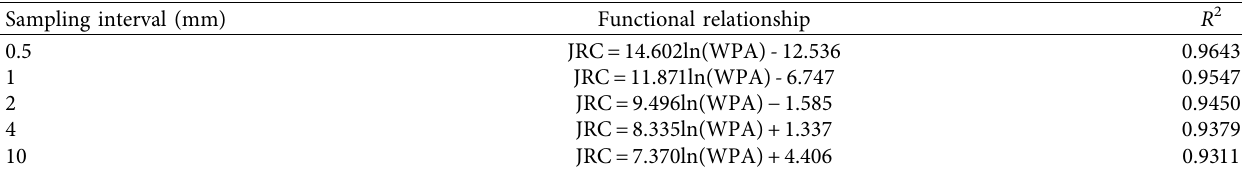
Table 5: The fitting formulas between WPA and JRC under different sampling intervals. Sampling interval